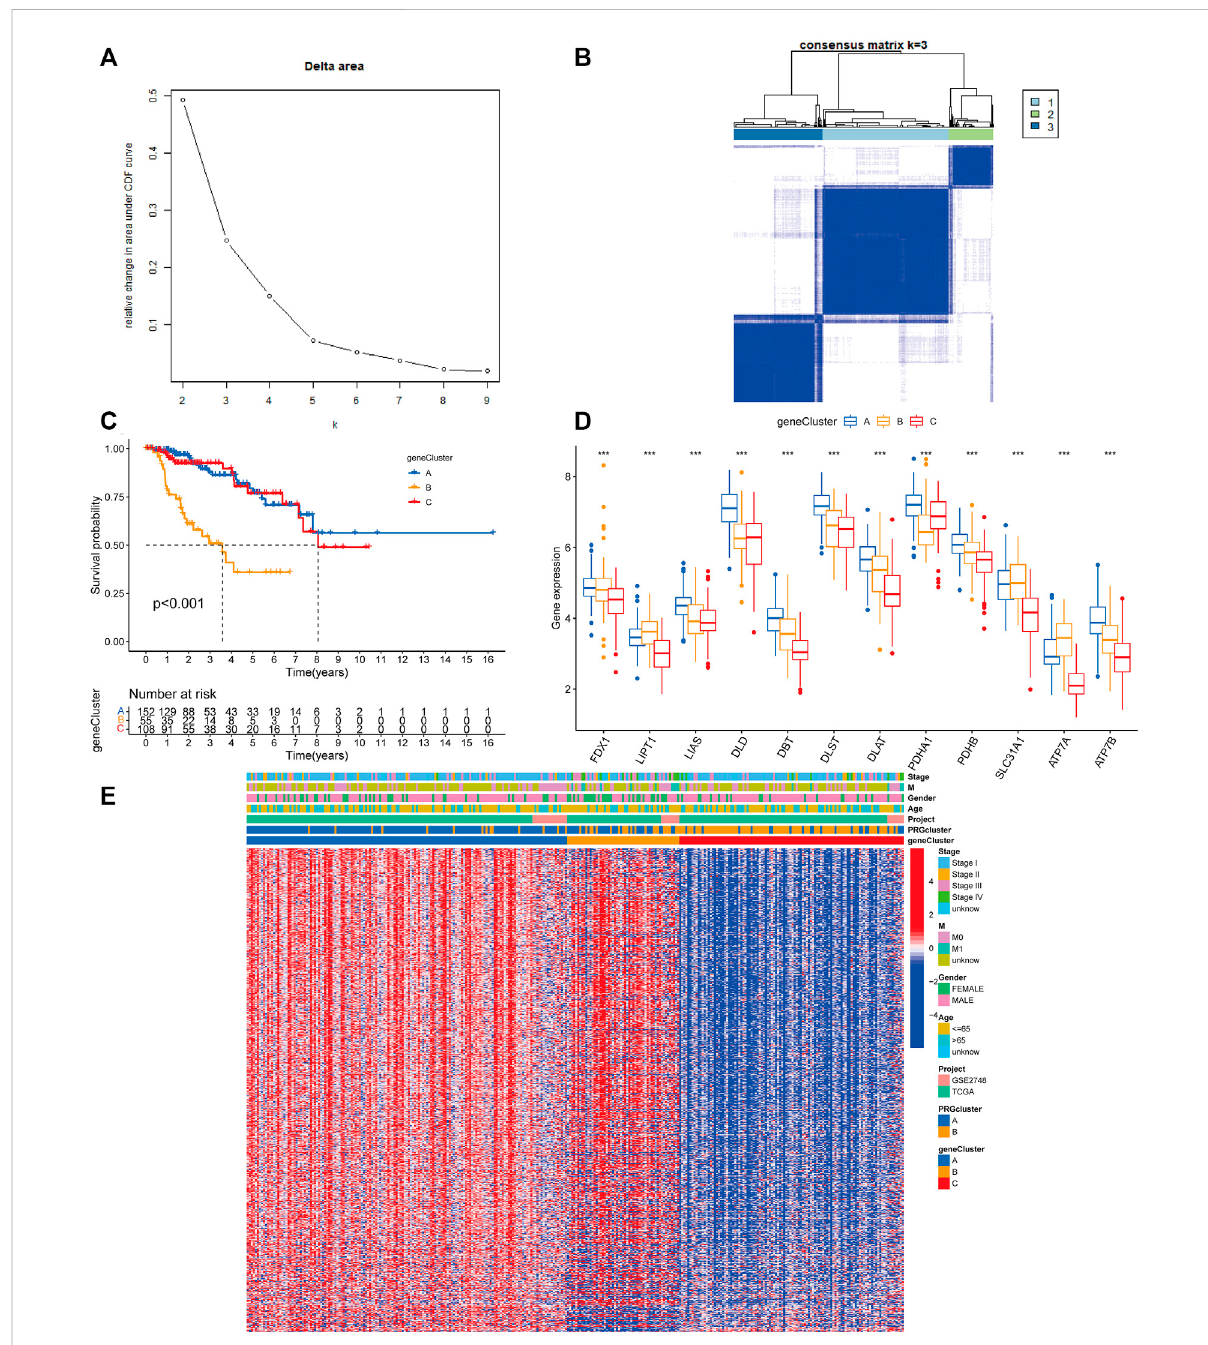
FIGURE 5 Geneclassi fi cationbasedondifferentiallyexpressedgenes. (A) ForK=2 – 9,therelativechangeintheareaundertheCDFcurve. (B) Heatmapof theconsensus matrixidentifyingtwoclusters(k=3)andtheregionoftheircorrelation.AtK=3,thesamplesarepartitionedwithreasonablestability. (C) Kaplan – Meier curves for the overall survival of the gene subclusters. Blue indicates gene cluster A, orange cluster B, and red cluster C. Log-rank p < 0.001, suggesting a substantial difference among the three gene clusters in terms of overall survival. Cluster B ’ s overall survival was much worsethanclustersAandC ’ s (D) CRGexpressiondifferencesbetweengenesubclusters.Aninterquartilerangeofthedatawasindicatedbytheupper and lower ends of the boxes. The boxes ’ lines indicated the median value. (one-way ANOVA test: *** p < 0.001). (E) A heat map of the clinical- pathologic correlations between the two gene clusters. Alternate annotations are provided for age, gender, pathologic staging, and gene clusters. Blue denotes low gene expression whereas red denotes high gene